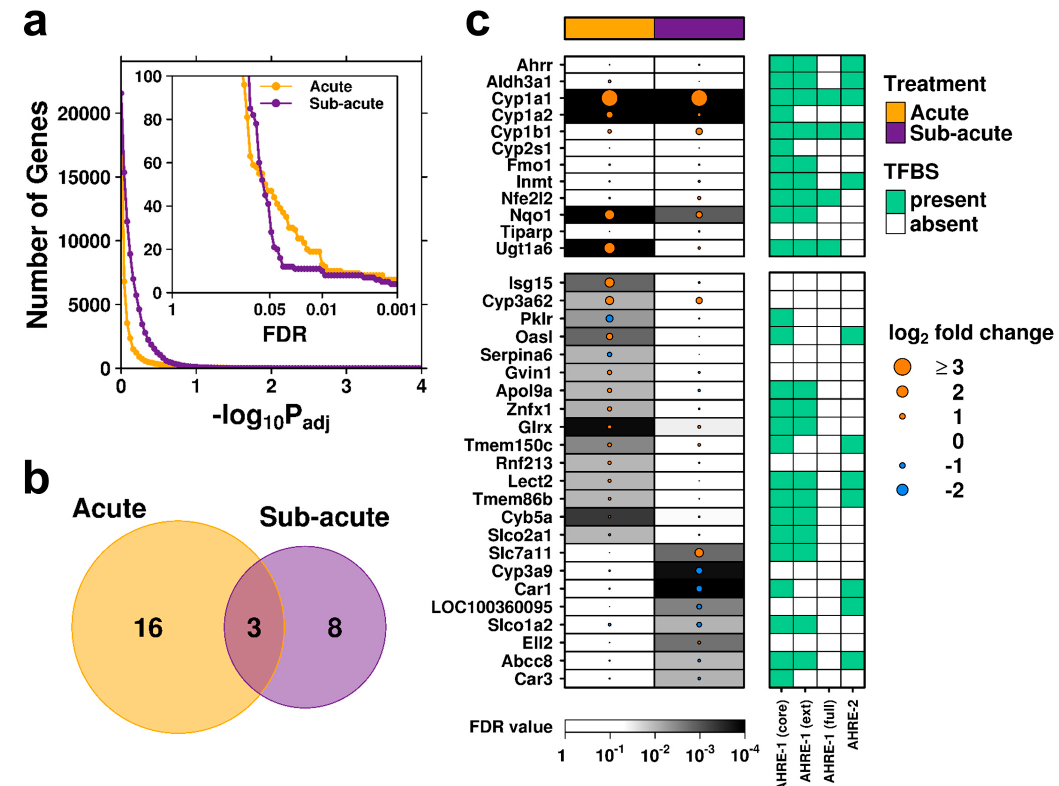
Figure 2. Transcriptomic profiles. ( a ) Following linear modeling, sensitivity to various FDR-adjusted p -value cut-offs was examined; yellow indicates genes determined to be significant in liver tissue from rats in the acute treatment group, while purple represents animals in the subacute treatment group. A FDR-threshold of 0.01 was selected, and genes with differentially abundant mRNA compared between treatments. ( b ) Venn diagram demonstrating the overlap of differentially expressed genes. ( c ) The magnitude and direction (log 2 -fold change) for genes with significantly differentially abundant mRNA, along with the standard ‘AHR-core’ gene battery are shown; dot size indicates magnitude of change, color indicates direction of change and background shading indicates statistical significance (FDR). Covariates (right) indicate presence (black) or absence (white) of described transcription factor binding sites.